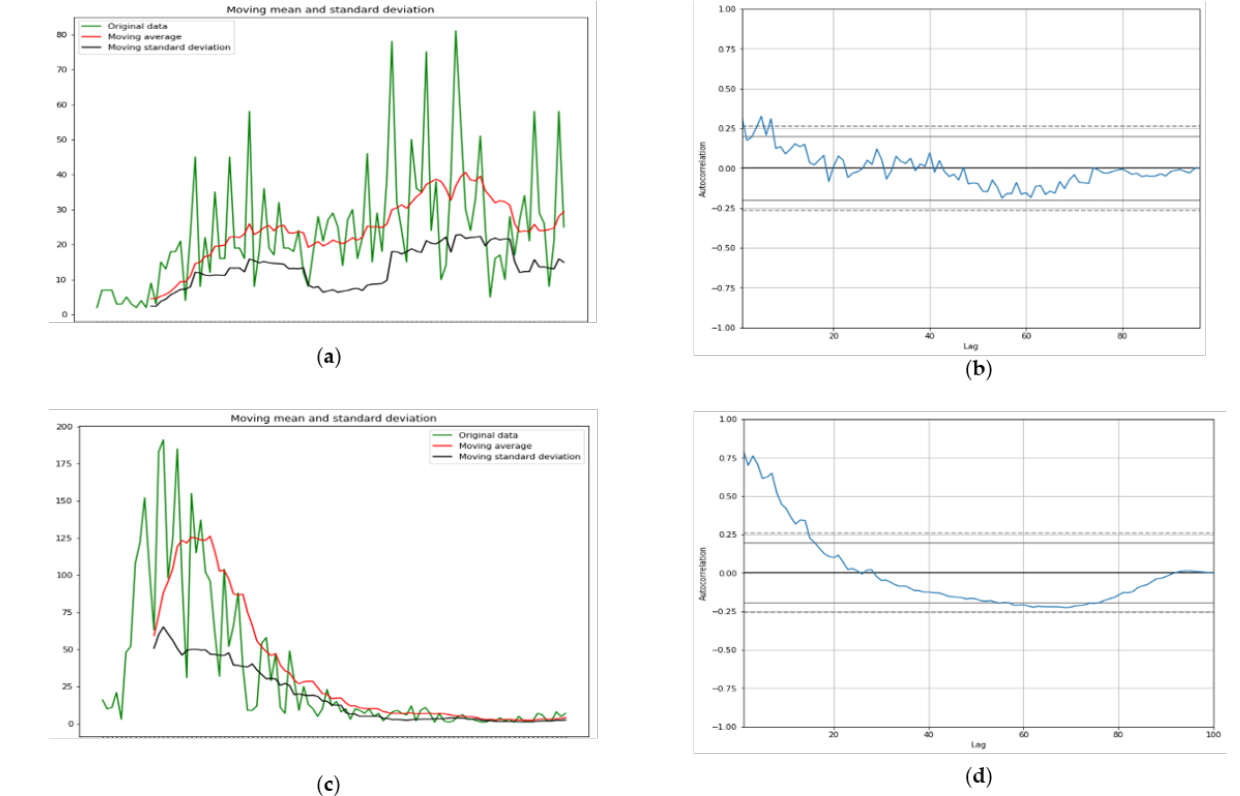
Figure 7. ( a ) First wave moving average and standard deviation of new cases (left) and ( b ) autocorrelation curve for Mali (right). ( c ) First wave moving average and standard deviation of new cases (left) and ( d ) autocorrelation curve for Luxembourg (right).